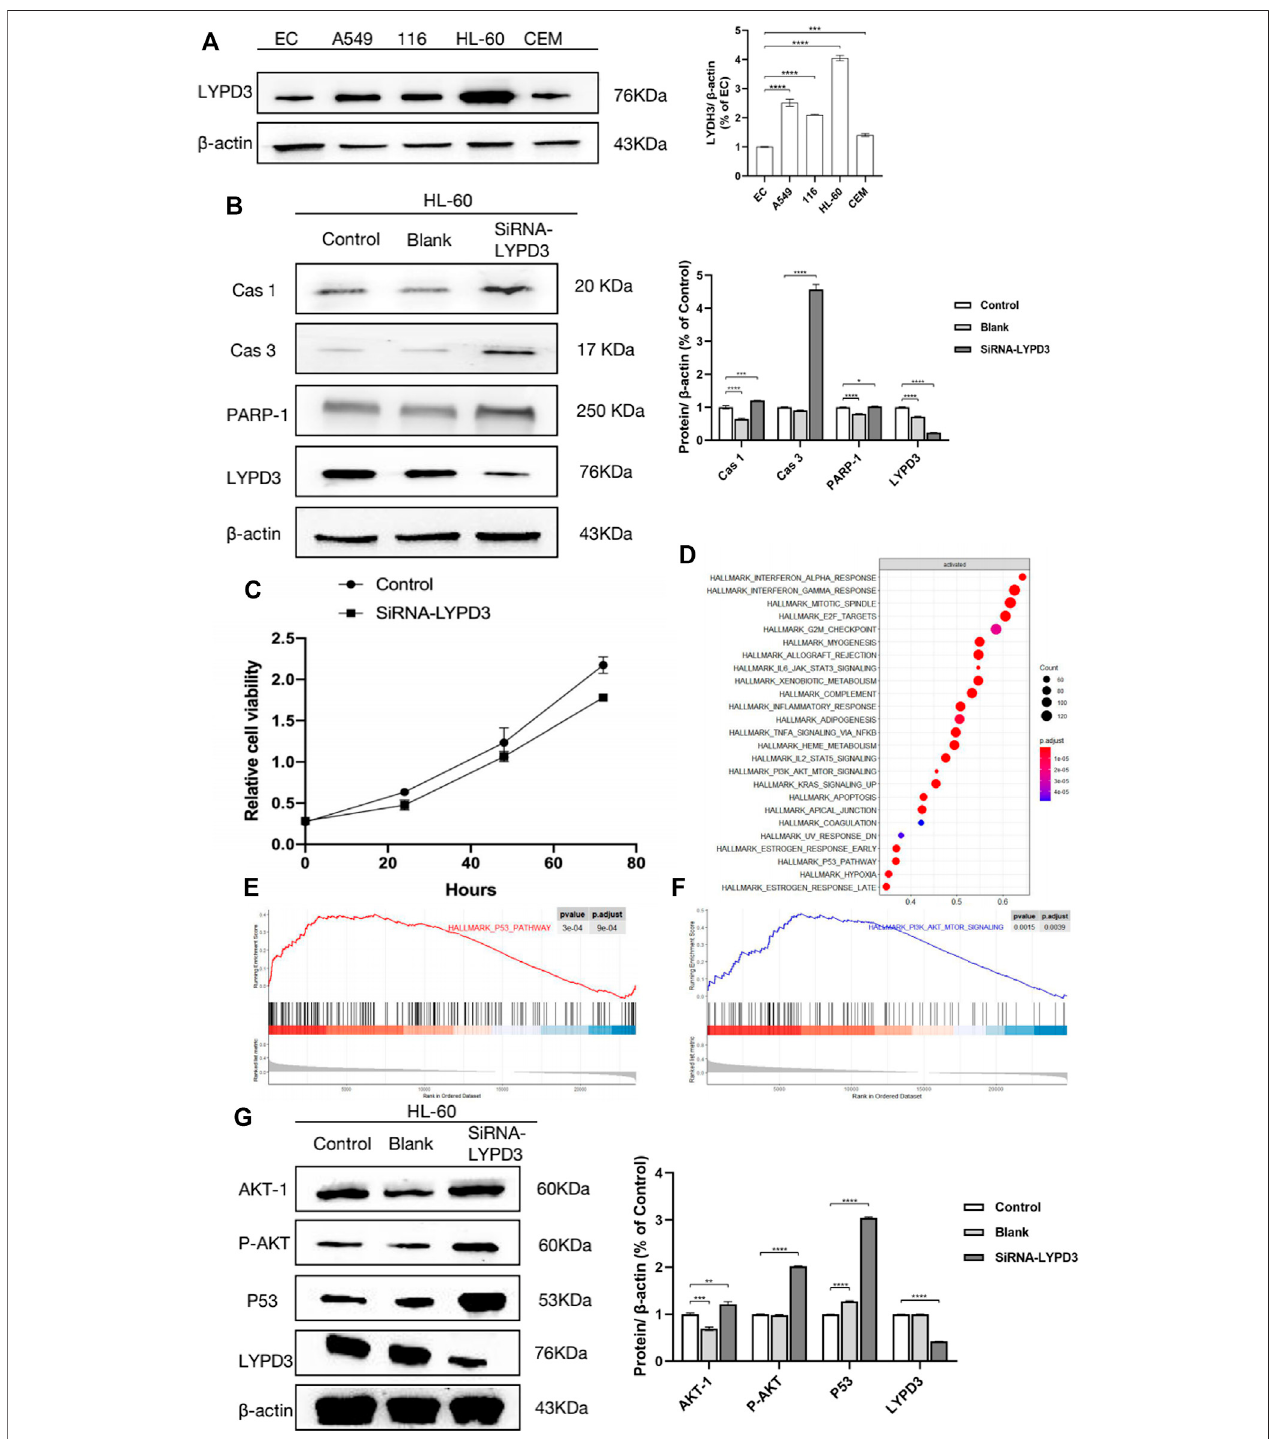
FIGURE 2 | (A) Expression of LYPD3 in cancer lines (the expression of LYPD3 is the highest in HL-60 cells); (B) LYPD3 gene knockdown mediated by siRNA- induced apoptosis in AML cells (HL-60 cells); (C) LYPD3 gene knockdown mediated by siRNA-suppressed proliferation in AML cells (HL-60 cells); (D) signi fi cantly enriched pathways in AML samples with high LYPD3 expression; (E) signi fi cantly enriched pathways (the P53 signaling pathways); (F) signi fi cantly enriched pathways (PI3K_AKT signaling pathway); (G) relationship between LYPD3 and the molecules Akt and P53 (the expression of the LYPD3 gene knockdown- mediated SiRNA group was obviously increased in p53 and PI3K_AKT signaling).